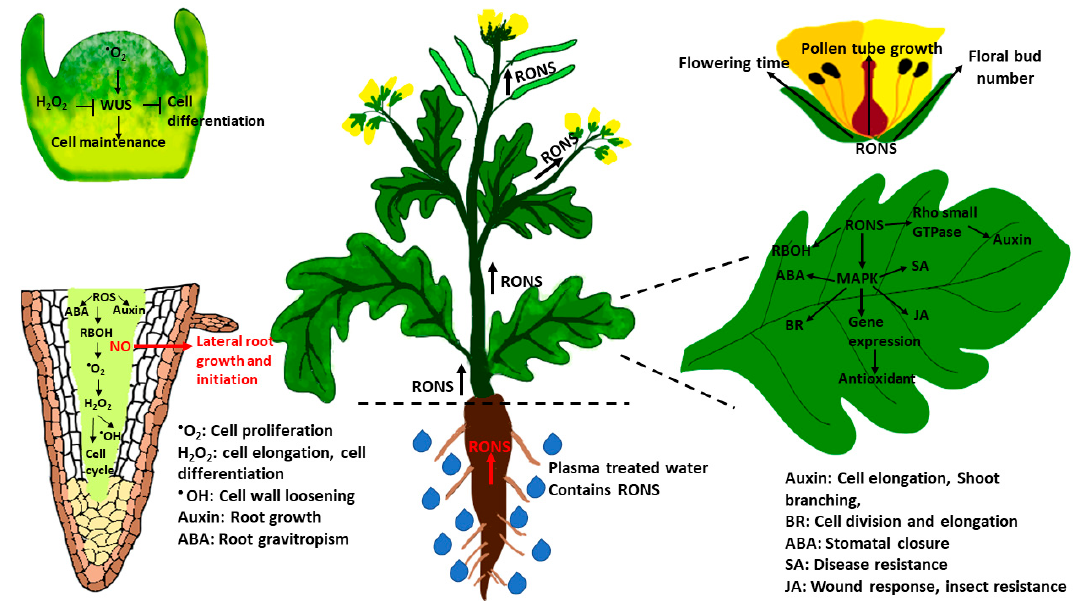
Figure 2. Effects of plasma-generated reactive oxygen and nitrogen species (RONS) in different plant organs at different growth stages. Direct and indirect exposure to plasma induces RONS in various plant organs (shoots, roots, leaves, and flowers) and activates different signaling cascades that crosstalk with other small signaling molecules and hormones to affect growth, development, and immunity. BR: Brassinosteroid, ABA: Abscisic acid, SA: Salicylic acid, JA: Jasmonic acid, MAPK: Mitogen activated protein kinase, WUS: WUSCHEL.